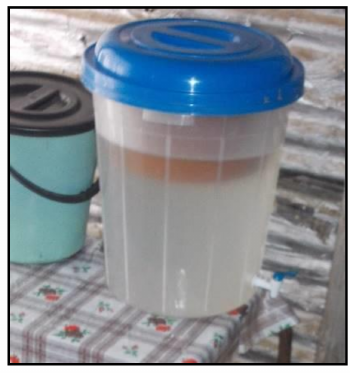
Figure 5. Ceramic pot